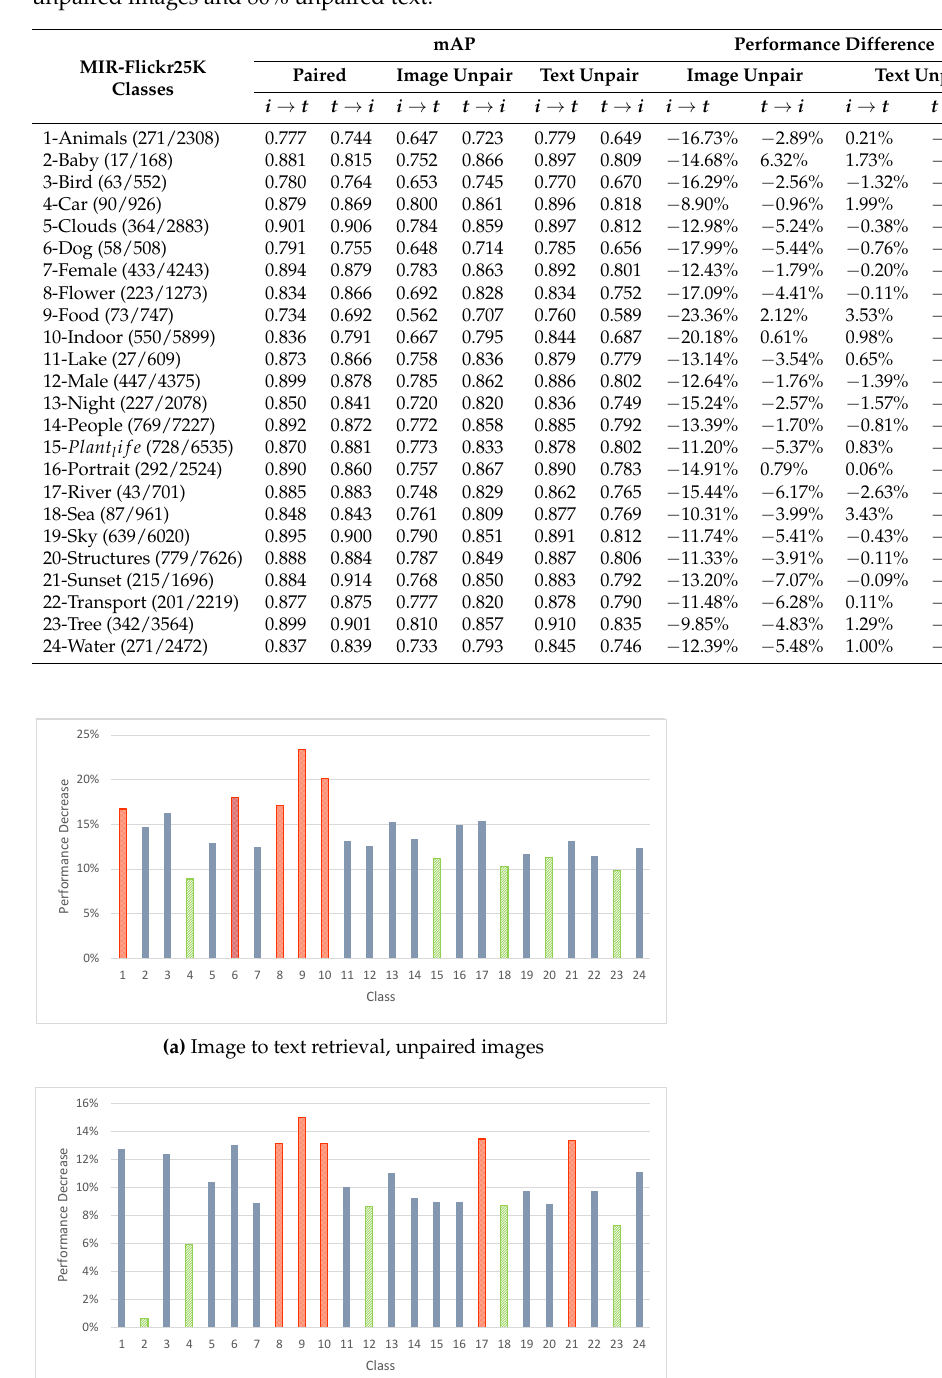
Table 9. MIR-Flickr25K class-by-class mAP@N evaluation using 64-Bit DADH. Fully paired, 80% unpaired images and 80% unpaired text.